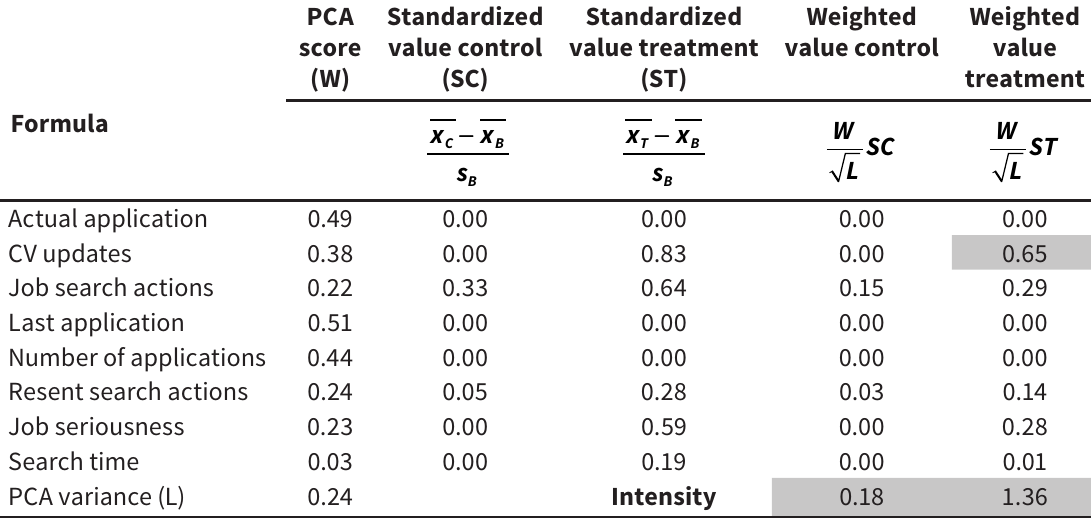
Intensity index